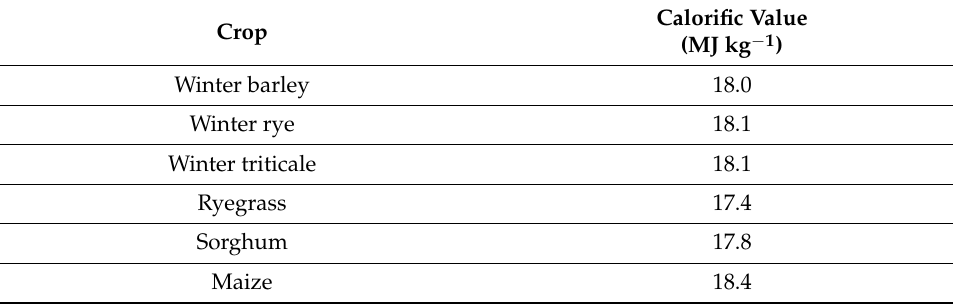
Table A7. Calorific value of crops across sites and trial